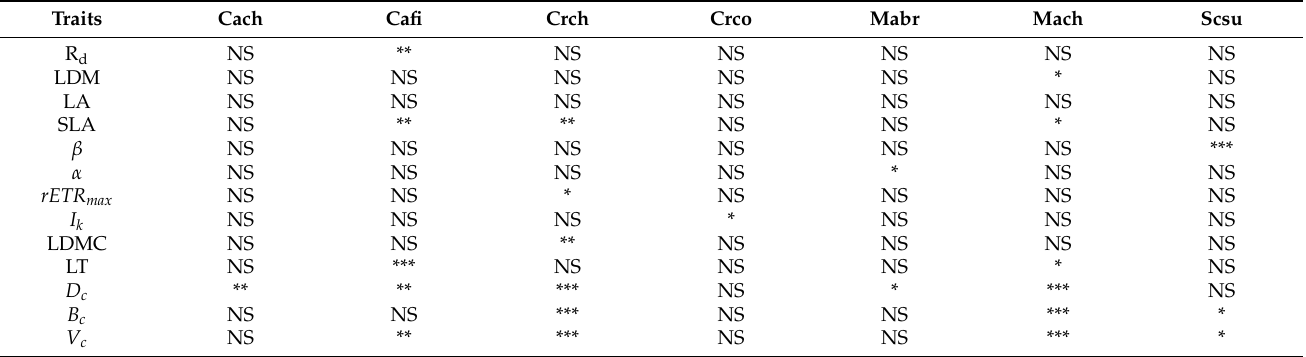
Table A5. The results of one-way analysis of variance (ANOVA) of intra-specific variability of functional traits across tree height of each